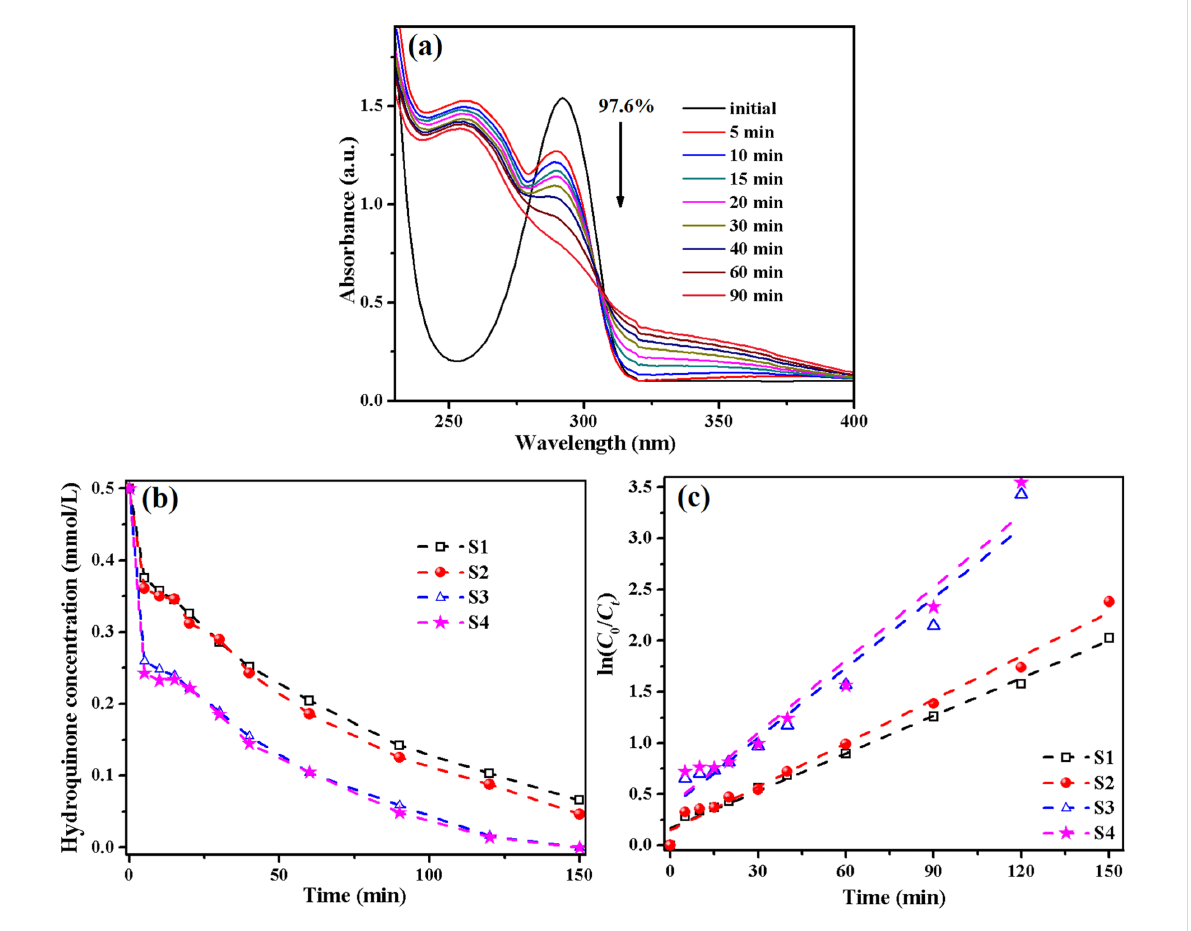
Figure 8: UV–vis absorption spectra of an aqueous hydroquinone solution in the presence of S4 film as a function of the UV irradiation time (a); temporal evolution of the hydroquinone concentration (b) and fitted curves for the kinetic estimation of hydroquinone photodegradation (c) in pres- ence of S1–S4